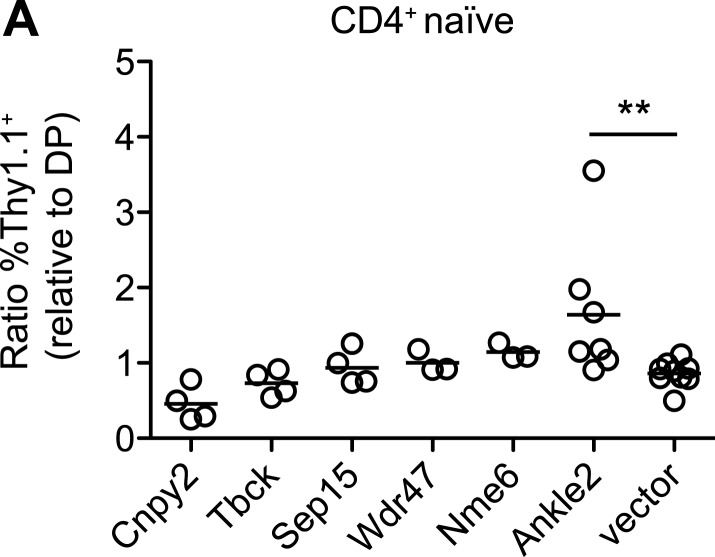
Ectopic expression of other Zfp335 target genes is not sufficient to
reverse the T cell maturation defect.(A) blt/blt bone marrow was retrovirally
transduced with Ankle2, Cnpy2, Nme6, Sep15, Tbck, Wdr47, or control
vector, and used to reconstitute irradiated chimeras. The normalized
ratios of %Thy1.1+ CD4+ naïve T cells relative to
%Thy1.1+ DP thymocytes are shown. Overexpression of Ankle2
yielded a ratio greater than that for vector control, suggesting it is
able to drive T cell maturation to some degree. Other constructs tested
either showed weak or insignificant effects (Nme6, Wdr47, Sep15, Tbck),
or may be inhibitory for maturation (Cnpy2). Each symbol represents one
chimeric mouse.; **p < 0.01 (one-tailed Mann-Whitney test).